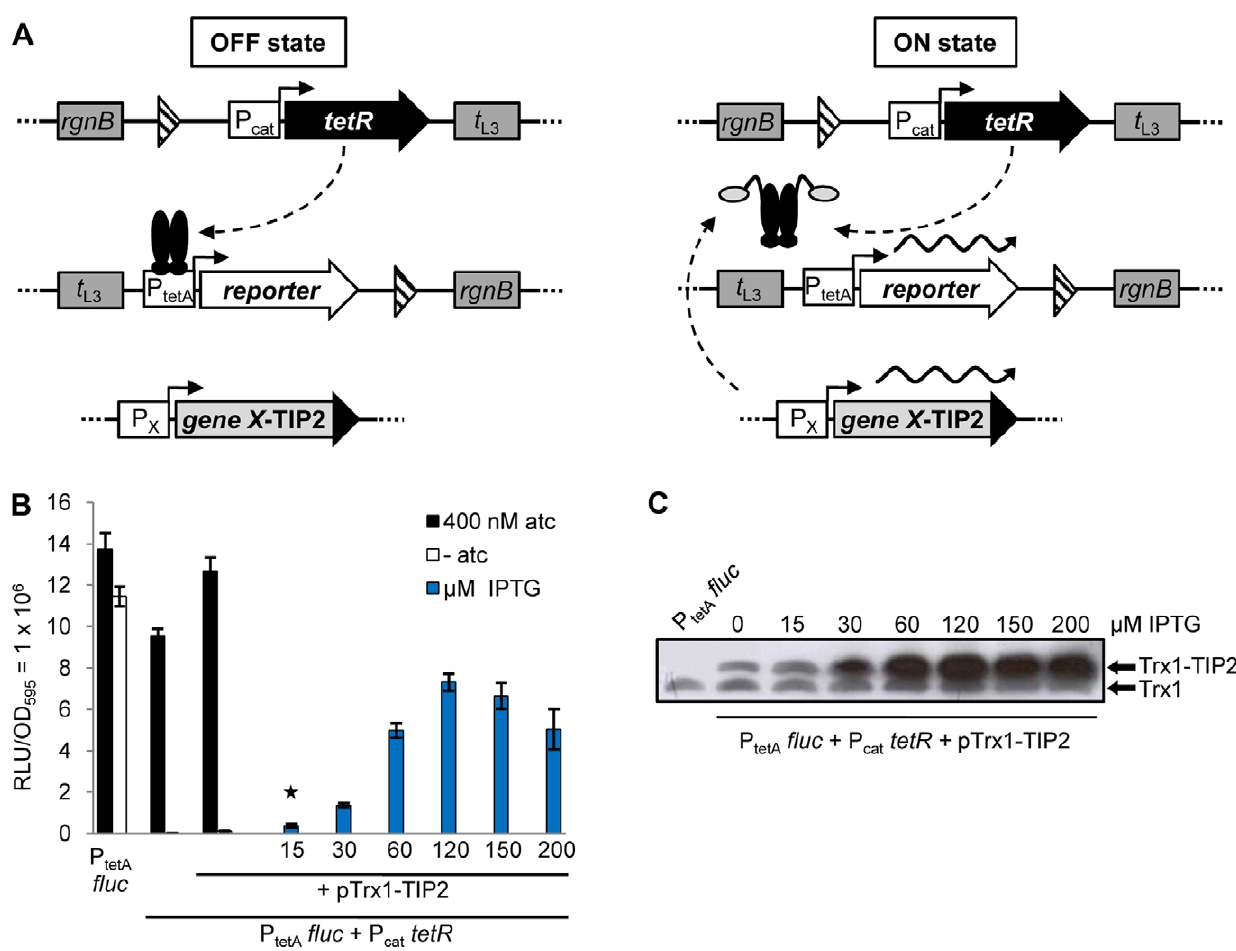
Figure 1. Design of the chromosomally-encoded Salmonella reporter system and analysis of its regulatory properties. (A) The tetR gene (black arrow) is expressed by P cat (promoters are depicted as white rectangles with arrows on top), the reporter gene ( fluc or gfp + , white arrow) is under control of P tetA . They are located in attachment sites of Salmonella Genomic Island 1 (2nd attB ) and phage P22, respectively. TetR (black ovals) is constitutively expressed by P cat and inhibits reporter gene transcription by binding to P tetA . If TetR is induced by tetracyclines or, as shown here, by a TIP2 fusion protein (light grey oval with black appendix), the reporter protein is expressed. The translational fusion of TIP2 to a target gene (light grey rectangle with black extension) is expressed either by the tac promoter when encoded on a plasmid or by the endogenous promoter when present in the Salmonella chromosome. All Salmonella reporter strains constructed possess flanking transcription terminators of bacterial ( rgnB ) and phage l ( t L3 ) origin (dark grey rectangles) that protect the integrated cassettes against transcriptional read-through. FRT sites are depicted by striped triangles. They remained as scars in the chromosome after excision of the kanamycin resistance cassette following homologous recombination. (B) Luciferase assay of a reporter strain as described in (A) with fluc serving as reporter gene, to compare induction of TetR by atc with induction by a plasmid-encoded Trx1-TIP2 fusion protein (pTrx1-TIP2). For maximum induction of TetR, 400 nM atc was added. Trx1-TIP2 expression was induced by increasing the concentration of IPTG. The bars illustrate the relative light units (RLU) which were normalized to a 1 ml culture with OD 595 =1. The data are a representative set from at least three independent measurements and display the mean 6 standard deviation. (C) Western blot analysis for detection of Trx1-TIP2 steady-state levels with a polyclonal anti-thio antibody. The reporter strain used in (B) was incubated with increasing amounts of IPTG and 5 m g crude protein extract from each sample were loaded onto the gel. to the tetracycline-binding pocket of TetR and elicit an allosteric